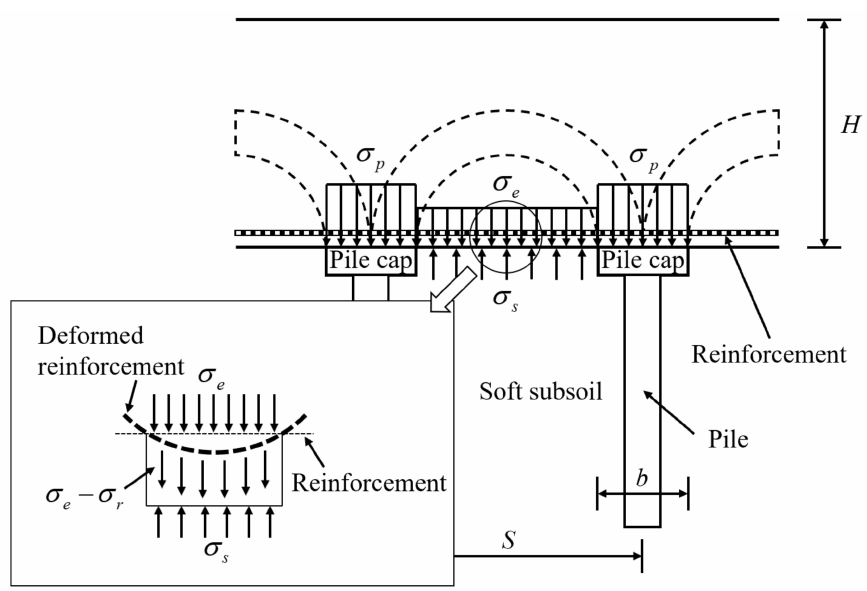
Figure 4. Stress analysis of the